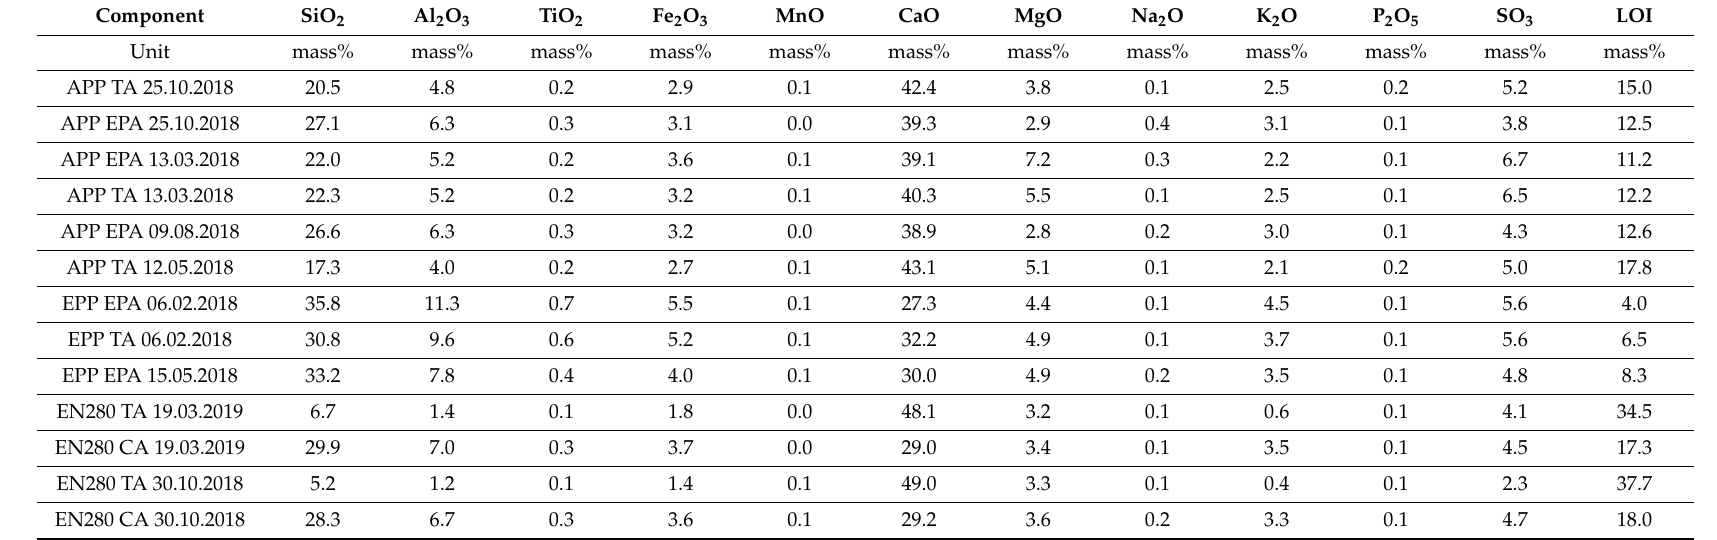
Table A3. Chemical composition of all oil shale